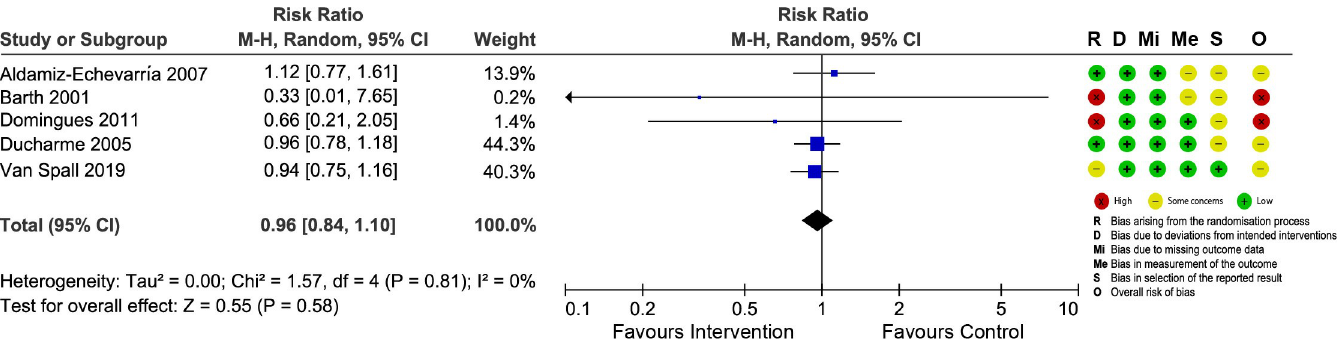
Fig 4. Forest plot showing the effect of nurse-led TCIs on emergency department visits and risk of bias assessment for each study.